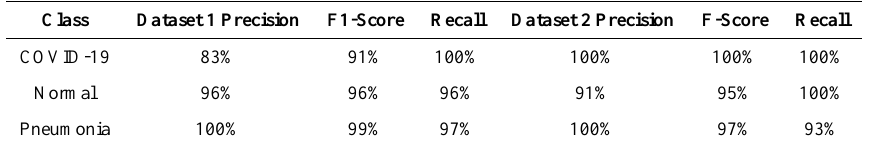
Table 9. Evaluation metrics of the CoroNet with the optimized data augmentation strategy on dataset 1 and dataset 2